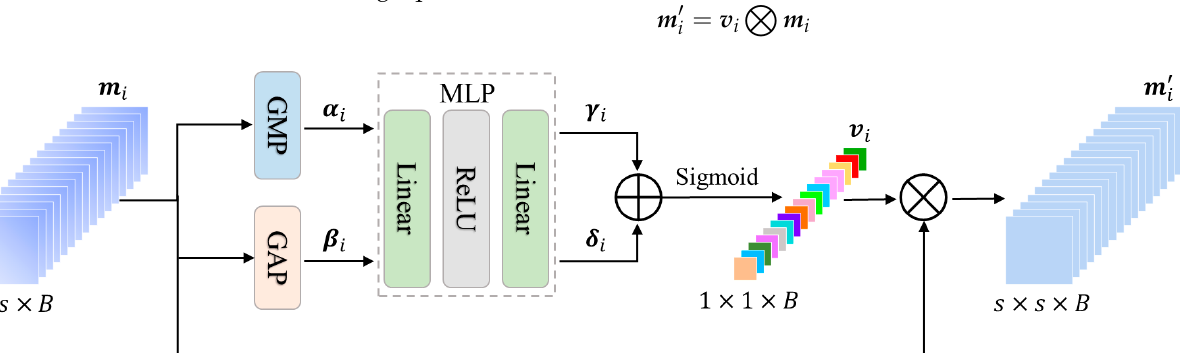
Figure 3. Detailed work fl ow of the SEAM.